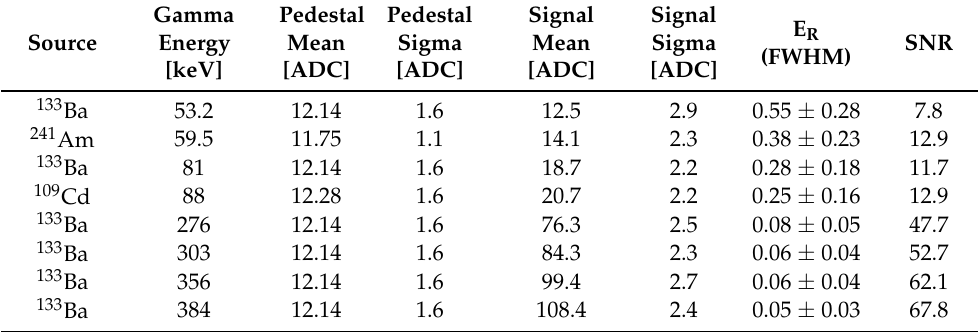
Table 1. Energy resolutions and signal to noise ratios for radioactive sources: 241 Am, 109 Cd, and 133 Ba.